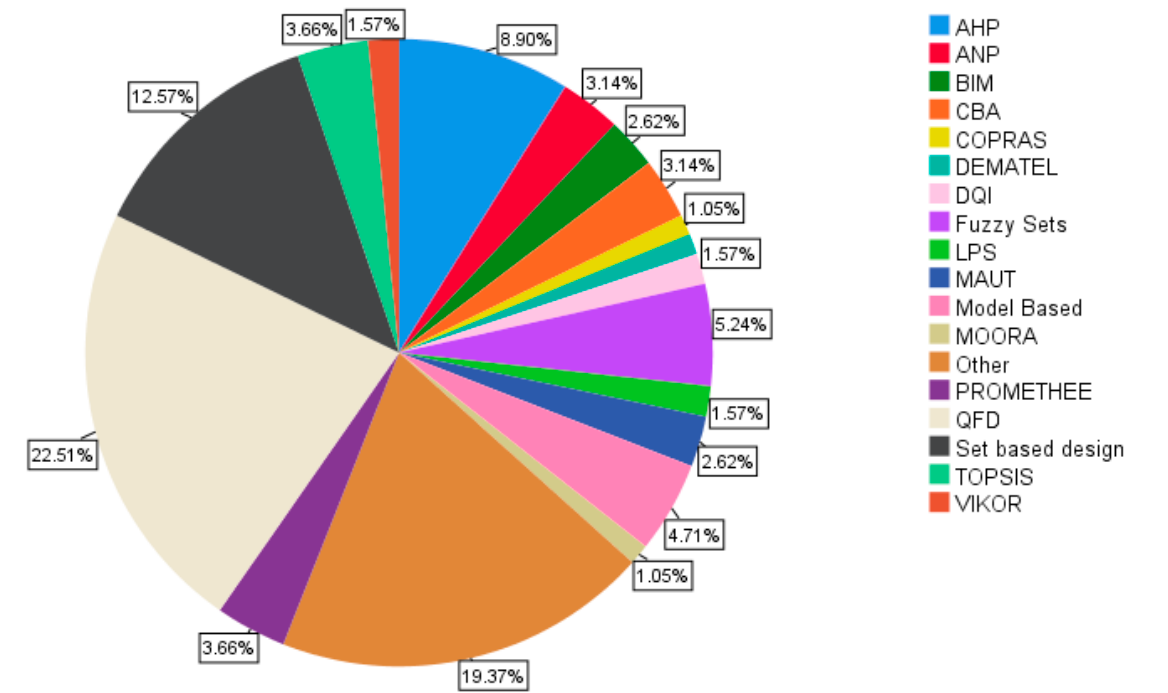
Figure 6. Decision techniques used in the review papers.